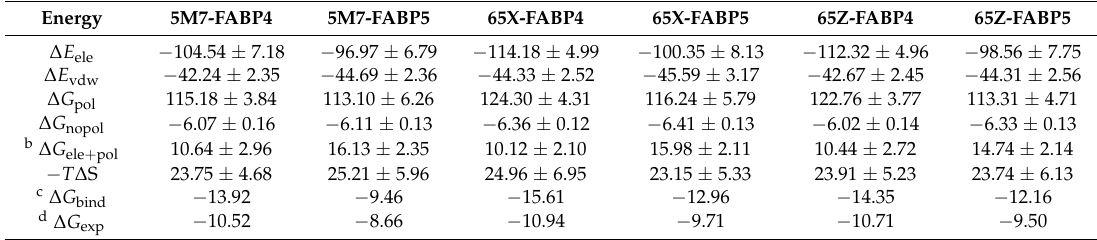
Table 1. Binding free energies of inhibitors to FABP4 and FABP5 calculated by molecular mechanics generalized Born surface area (MM-GBSA) method a